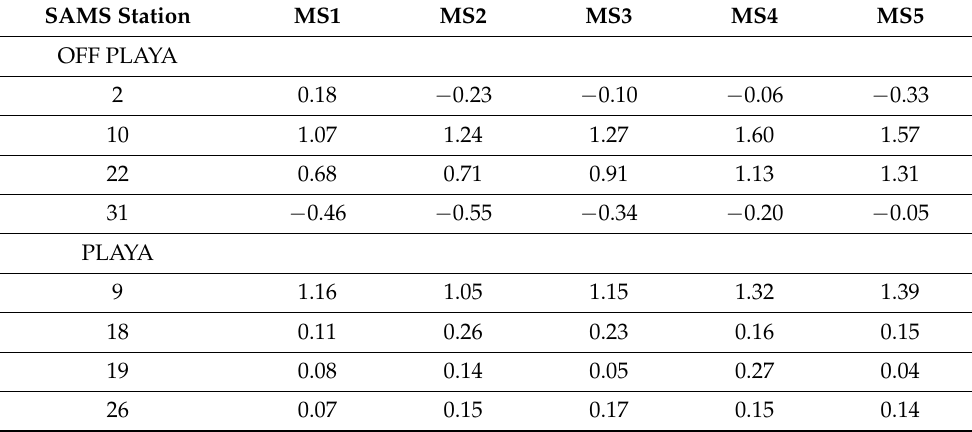
Table 4. Aggregate 10 m AGL u-wind component mean bias values for each model